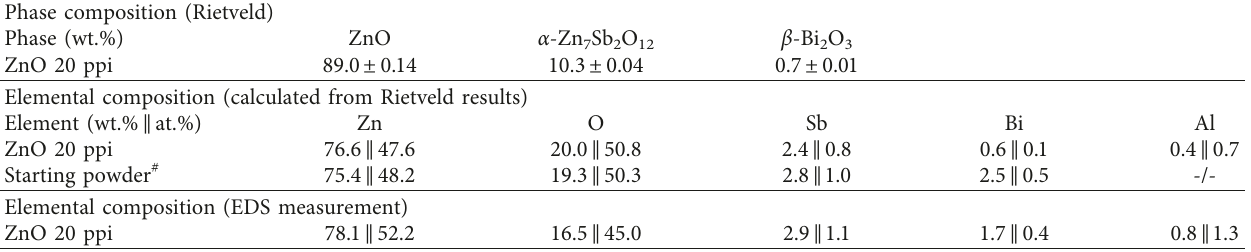
Figure 3: Powder XRD pattern of the ZnO strut material and the corresponding Rietveld fit revealing the individual phase contents of hexagonal ZnO, cubic α -Zn 7 Sb 2 O 12 , and tetragonal β -Bi 2 O 3 . Deposition numbers of the crystal structure data used for the Rietveld analysis (Crystallography Open Database, COD/Inorganic Structural Database, ICSD): ZnO: COD-9004178, α -Zn 7 Sb 2 O 12 : COD-1007077, and β -Bi 2 O 3 : ICSD-41764. Table 1: Phase and elemental composition of open-celled zinc oxide ceramic foams determined by powder XRD with Rietveld analysis and a comparative EDS